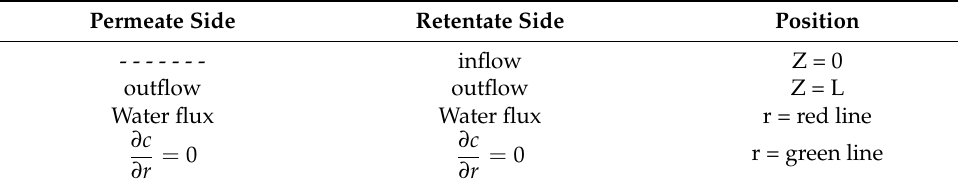
Table 5. Boundary conditions on the retentate and permeate sides. Permeate